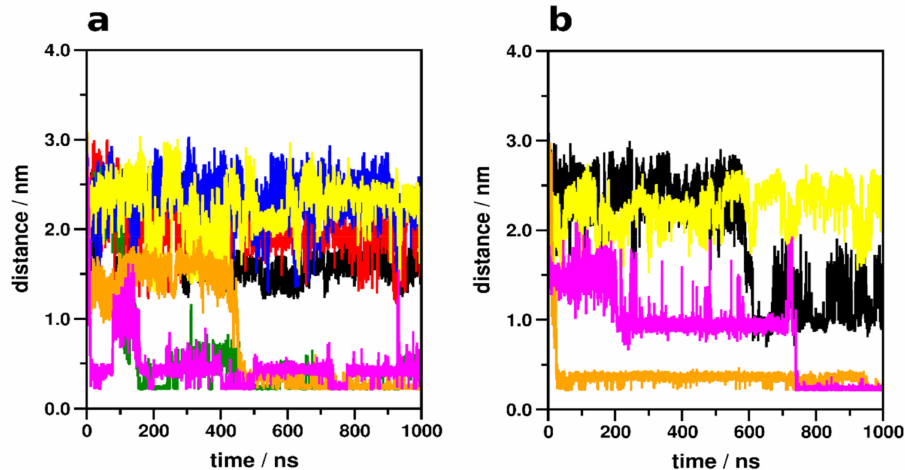
active ( a ) and inactive state ( b ) β 2 AR during simulations. Black: β 2 AR–G s protein–epinephrine complex, 1st replica; Red: β 2 AR–G s protein–epinephrine complex, 2 nd replica; Green: β 2 AR–G s protein–epinephrine complex, 3 rd replica; Blue: β 2 AR–G s protein–epinephrine complex, with re- strained epinephrine and GDP; Yellow: β 2 AR- β -arrestin-2–epinephrine complex; Orange: ligand-free β β β -arrestin-2 2 AR–G s protein complex; Magenta: ligand-free 2 AR-